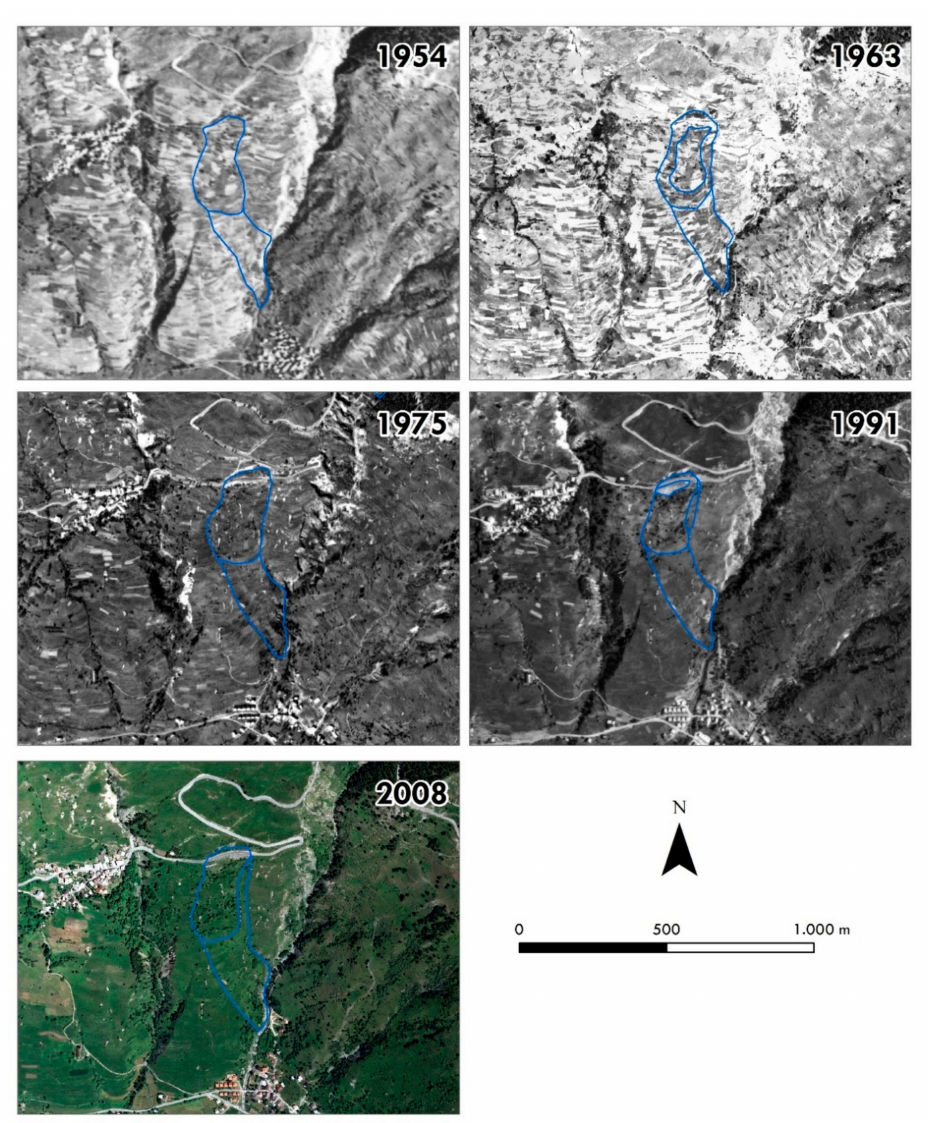
Figure 6. Orthoimages processed by SfM for the Champlas d Col area; the blue polygons represent the photo-interpreted Champlas du Col landslide